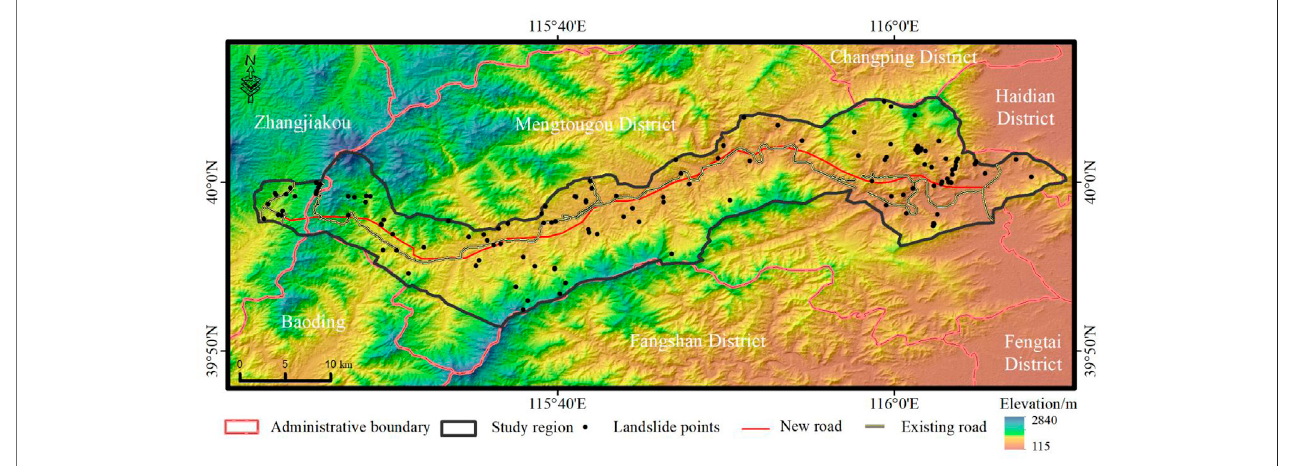
FIGURE 1 | Location of the study area and distribution of the